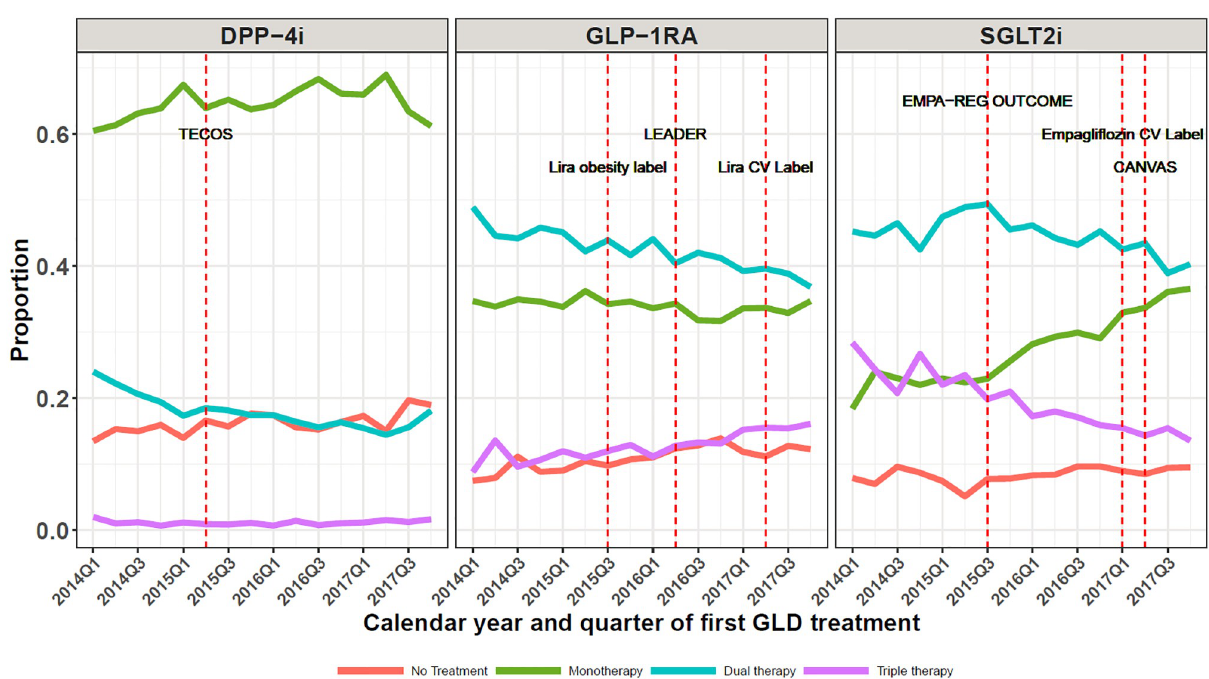
Fig 2. Time trends in proportions using various baseline glucose-lowering drug regimens at the time of initiation of DPP-4i, GLP-1RA, and SGLT2i, respectively. Graphs show the proportion of patients who–at the time of their first initiation of either DPP-4i, GLP-1RA, or SGLT2i –are on no other GLD treatment (red graph), on another GLD monotherapy (green graph), on dual GLD therapy (blue graph), or on triple GLD therapy (purple graph). DPP-4i: dipeptidyl peptidase-4 inhibitor; GLP-1RA: glucagon-like peptide-1 receptor agonists; SGLT2i: sodium-glucose cotransporter 2 inhibitors; TECOS: Sitagliptin (DPP-4i) showed non-inferiority to placebo [35]; Lira obesity label: Liraglutide 3 mg launched as treatment for obesity; EMPA-REG OUTCOME: empagliflozin showed CV and CV/all-cause mortality benefits [10], LEADER: liraglutide showed CV and CV/all-cause mortality benefits [12]; CANVAS: canagliflozin showed CV benefits